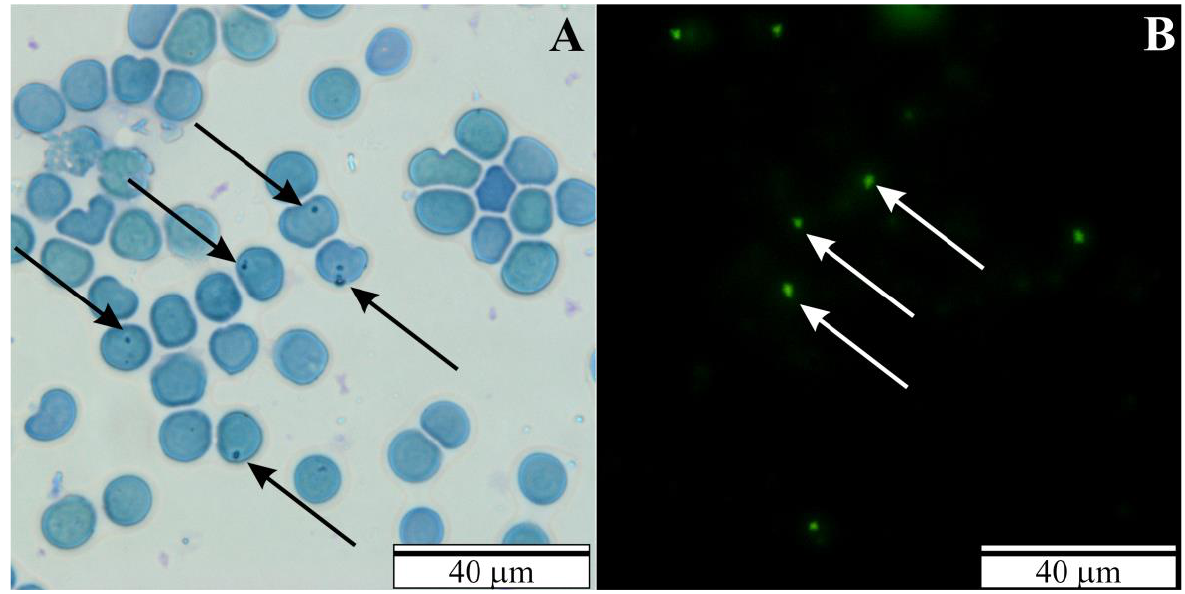
Figure 1. Blood smears from the rats examined with congenital babesiosis. Black arrows— B. microti merozoites ( A ) MGG stained and ( B ) FISH stained. White arrows— B. microti merozoites. DNA labeling of B. microti in kidney and spleen sections has proven the presence of B. microti merozoites in these tissues (Figure 2A,B).